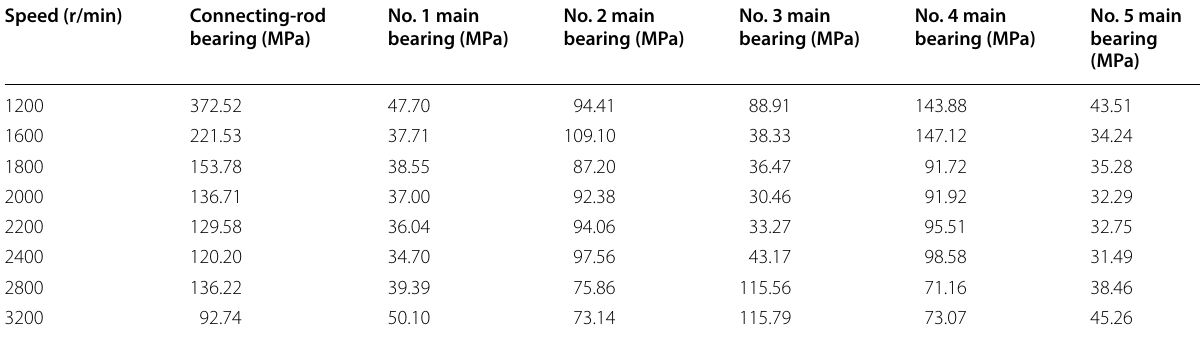
Table 4 Maximum film pressures of connecting‑rod bearing and main bearings at full load and different speed Speed (r/min)